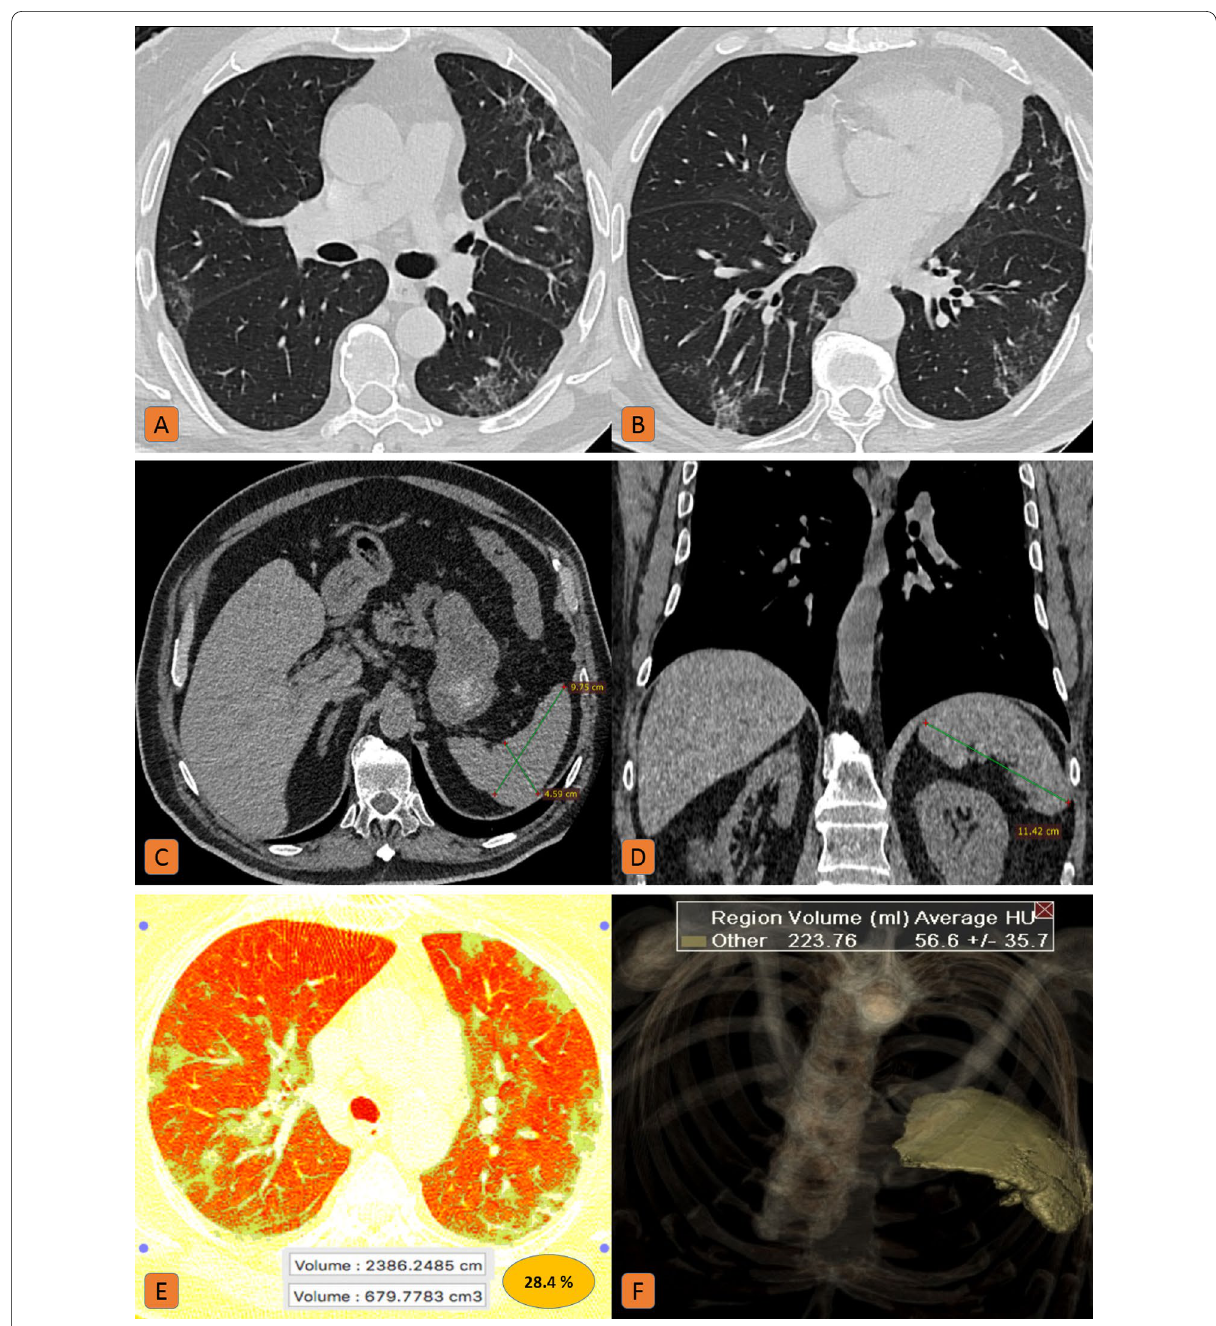
Fig. 1 Normal sized spleen in a 74-year-old male patient with severe COVID-19 infection: A , B Axial chest CT (lung window) showed bilateral sub-pleural ground-glass patches with mild reticular thickening. C Axial, and D coronal CT cuts of the upper abdomen (soft tissue window) showed normal splenic diameters. E Lung volumetric CT assessment revealed 28.5% pathological lung involvement. F CT volumetry of the spleen was 223